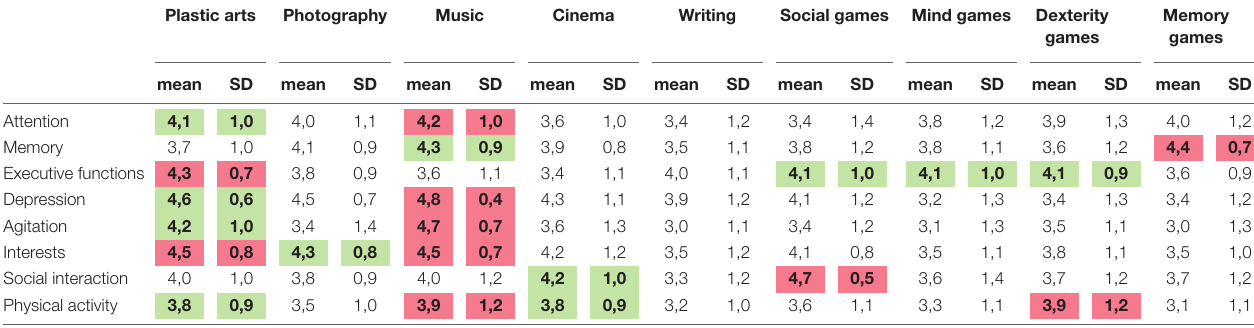
TABLE 3 | Mean ratings on the interest of using different types of arts and games for specific disorders. Plastic arts